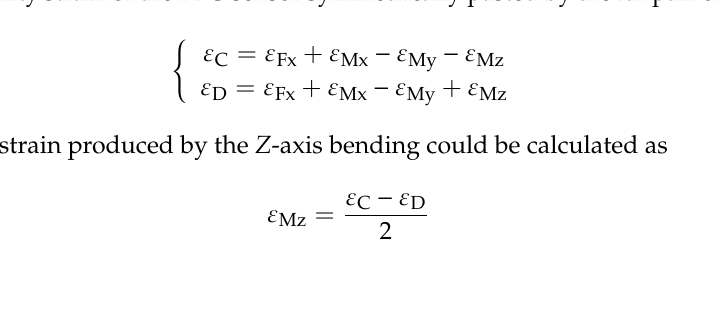
Figure 4. Schematic diagram of deformation measurement of FBG sensor on the lower surface.